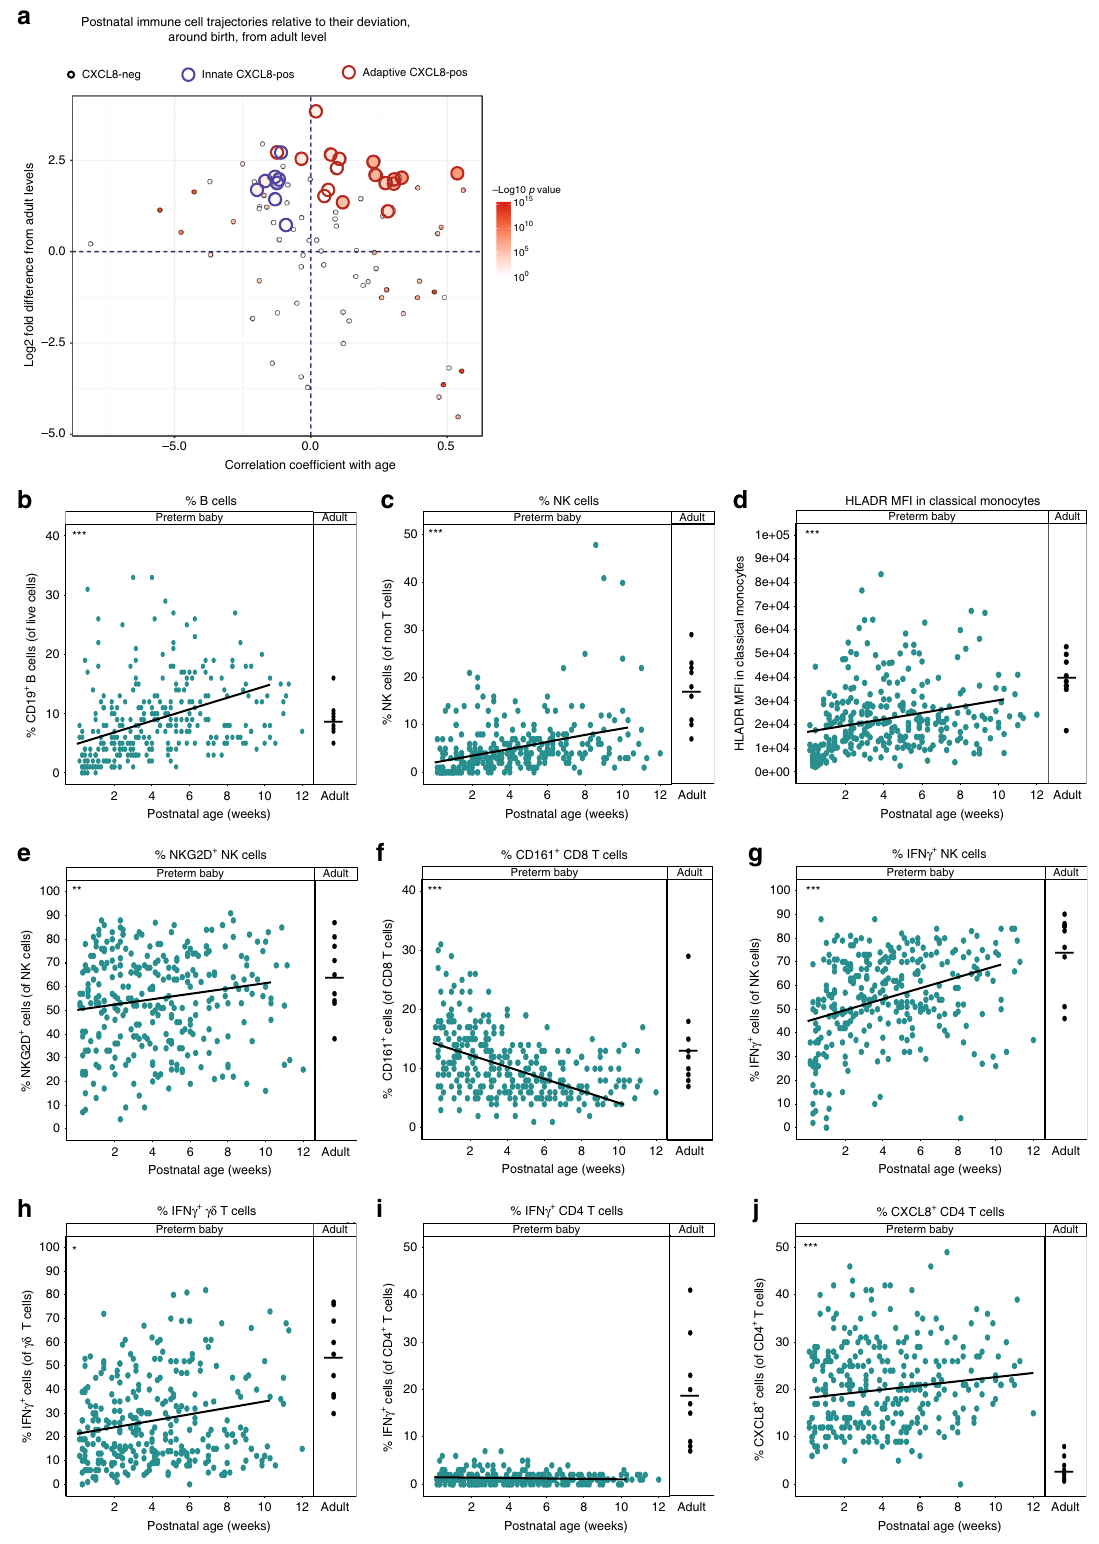
microbiome, we considered the effects of both pre- and postnatal exposure to infection on the developing immune system. Ana- lyses of the whole immune pro fi les by PCA for the different clinical groups described in Table 1 identi fi ed distinct immune signatures in babies who had experienced different pre- and postnatal exposures to the stable infants (Fig. 5a, b). Babies